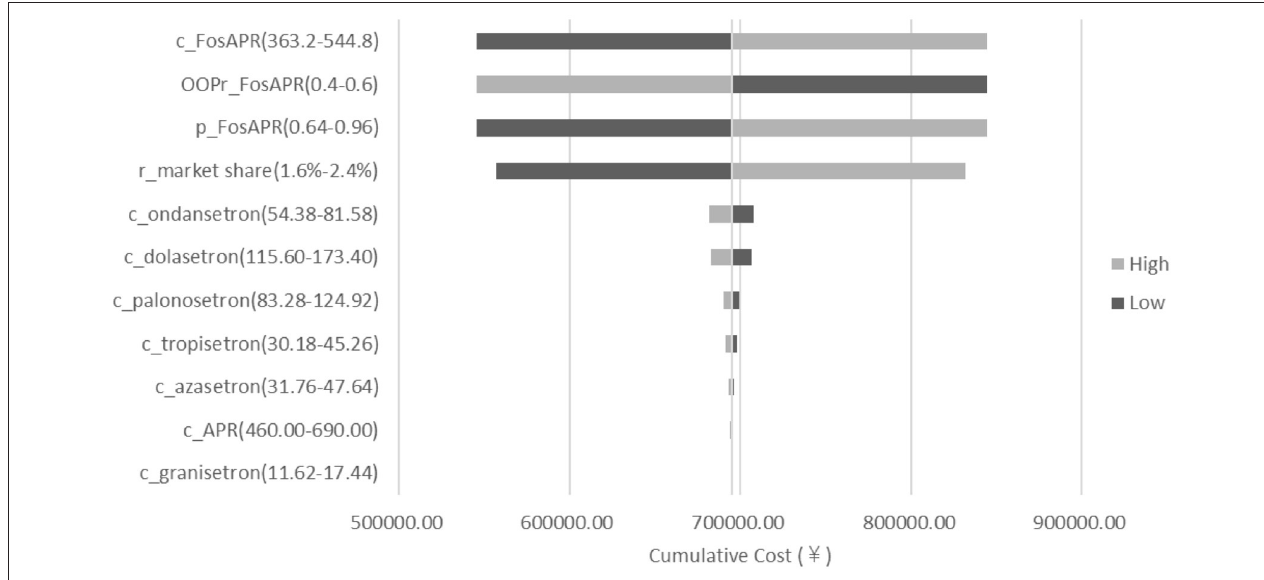
FIGURE 5 | Deterministic sensitivity analysis tornado diagram of FosAPR in BIA. c, cost; p, proportion of reimbursement; OOPr, out-of-pocket ratio; r_market share, ratio of market share